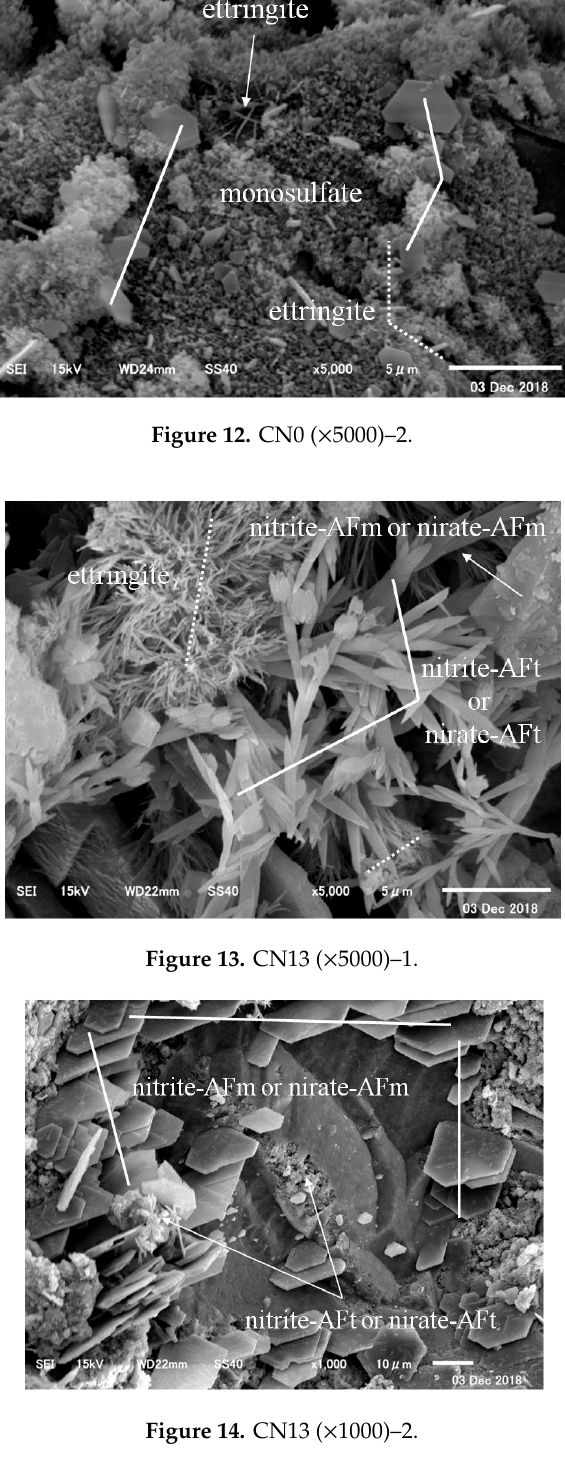
Figure 14. CN13 (×1000) – 2.